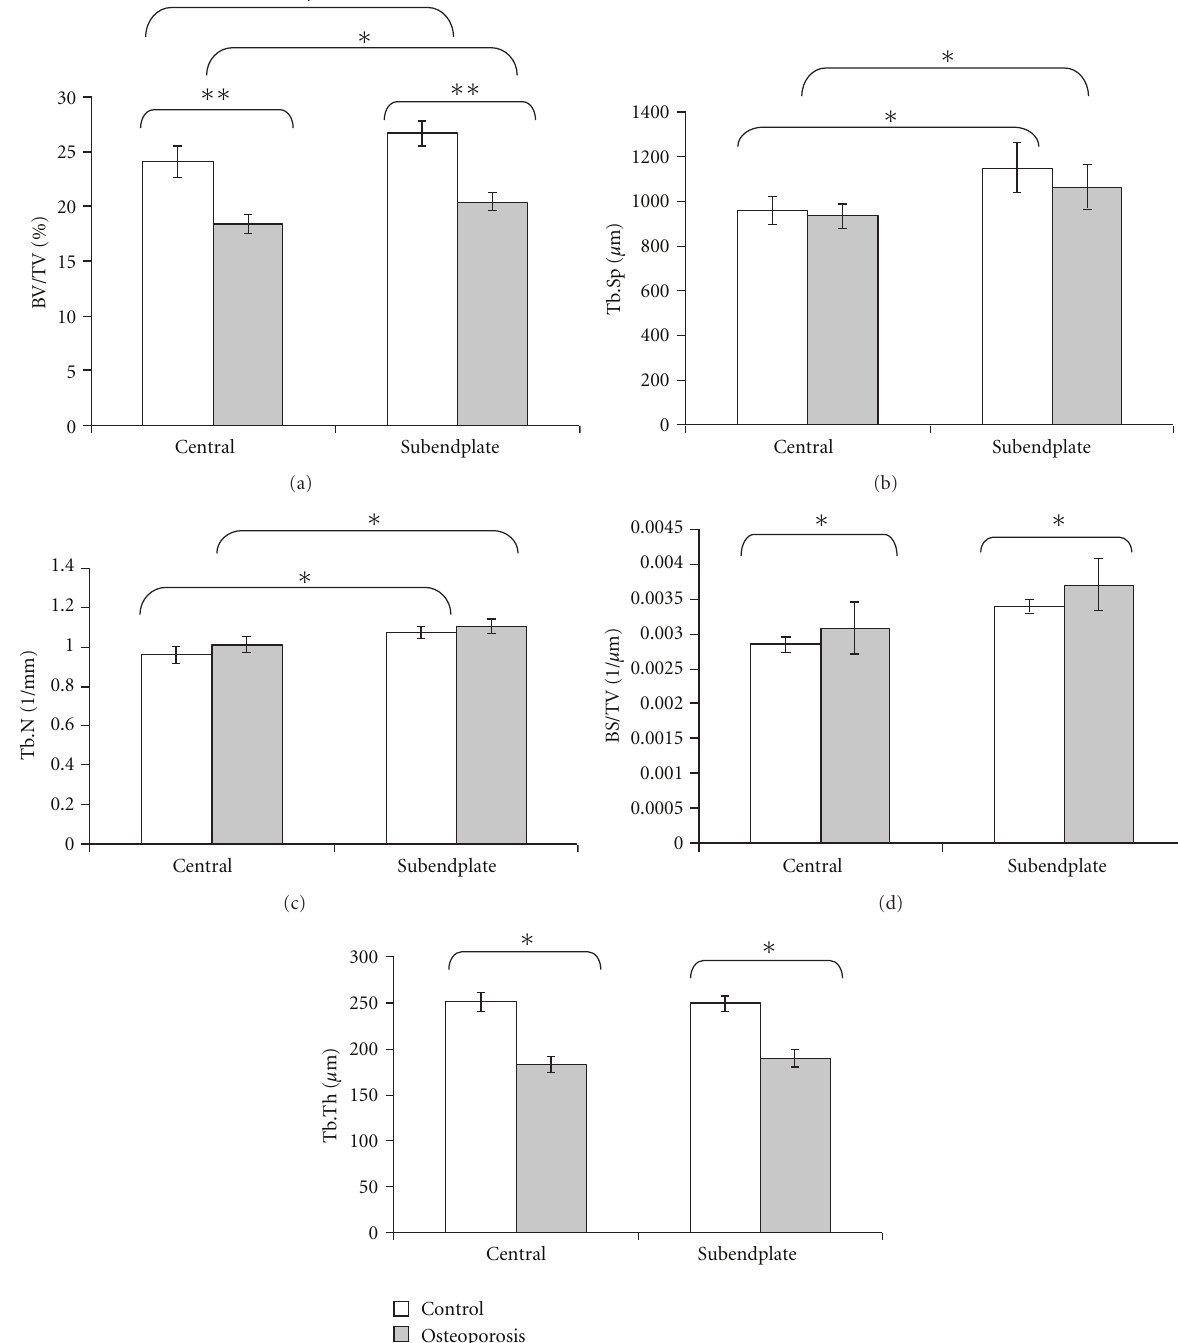
Figure 4: Comparison of histomorphometric indices of trabecular bone from di ff erent regions of lumbar vertebrae in control and osteoporotic sheep ( ∗ P < 0 . 05, ∗∗ P < 0 .